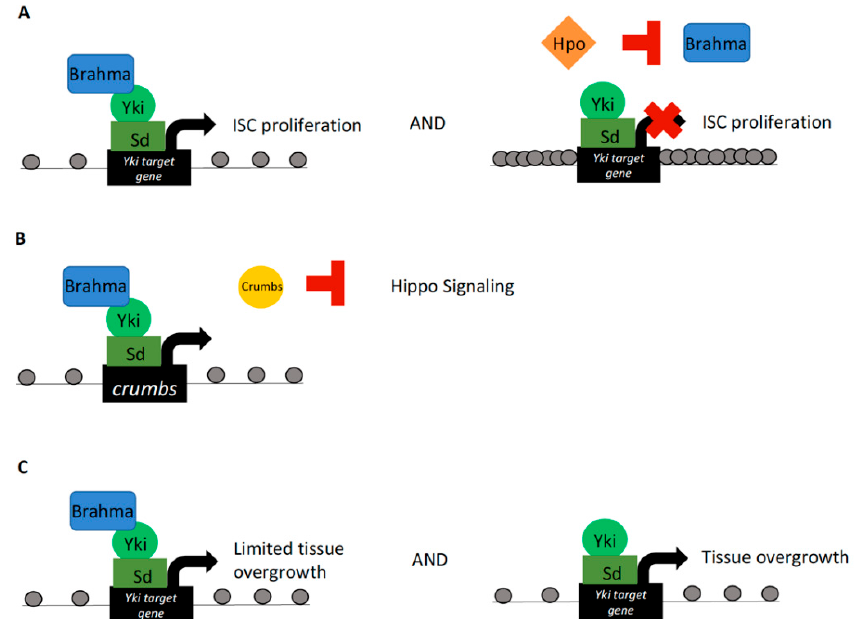
Figure 1. Yorkie interactions with the SWI / SNF complex. ( A ) Brahma and Yki–Sd interact to drive Drosophila midgut intestinal stem cell (ISC) proliferation. Notably, cotransfection with Hippo results in caspase-mediated proteolysis of Brahma and loss of complex stability. ( B ) Brahma has also been shown to interact with Yki–Sd at Yki target genes to promote tissue overgrowth in the wing disc and eye. This interaction occurred at the crumbs locus, providing evidence for a feed-forward loop of Crumbs-mediated Yki activation in regulation of tissue growth in Drosophila . ( C ) In the Drosophila wing imaginal disc, yki overexpression drives tissue overgrowth. This overgrowth phenotype was exacerbated by brahma knockdown, providing evidence for a regulatory role of Brahma in limiting Yki-mediated tissue overgrowth. Spacing of grey dots, representing nucleosomes, represents chromatin compaction.